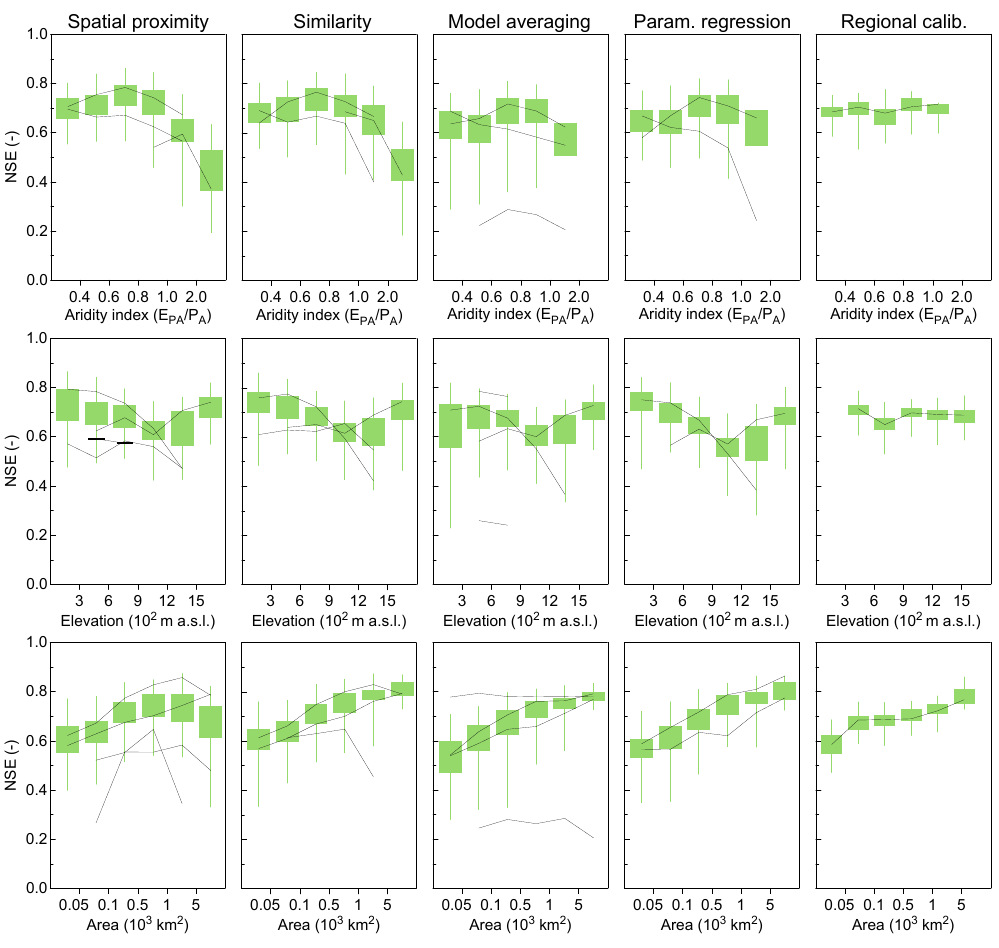
Fig. 7. Nash–Sutcliffe efficiency of predicting hydrographs in ungauged basins as a function of aridity ( E PA / P A ) , mean elevation and catchment area for different parameter regionalisation methods (Level 2 assessment). Lines connect median efficiencies for the same study. Boxes are 40–60% quantiles, whiskers are 20–80%